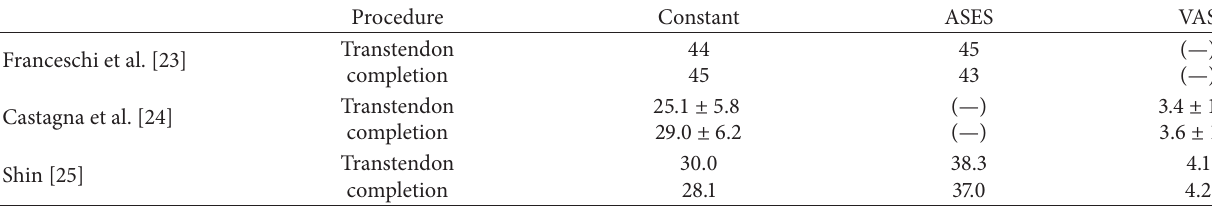
Table 3: Study outcomes.